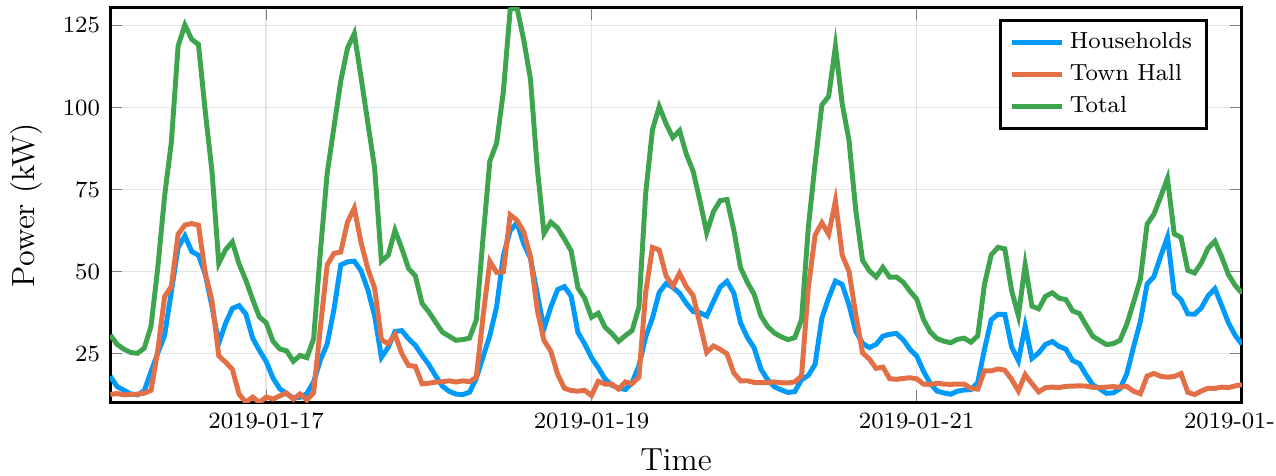
Figure 2. Consumption of the community for a winter week (January).